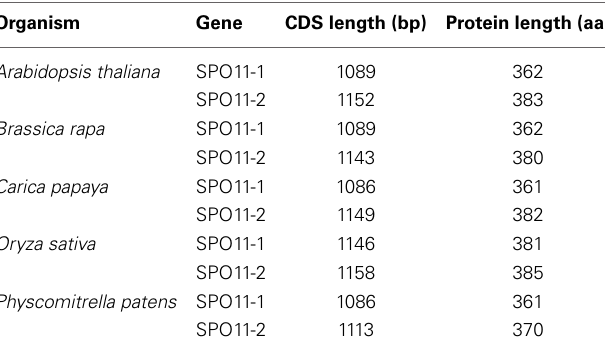
Table 2 | Length of the coding sequence and the respective deduced protein length of SPO11-1 and -2 from different species.